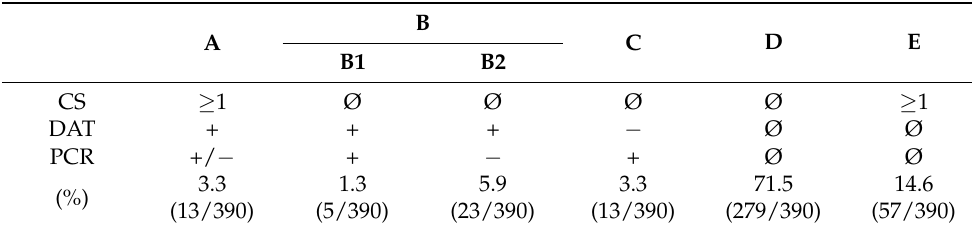
Table 1. Classification of PT cohort in groups according to their parasitological, clinical, and serologi- cal